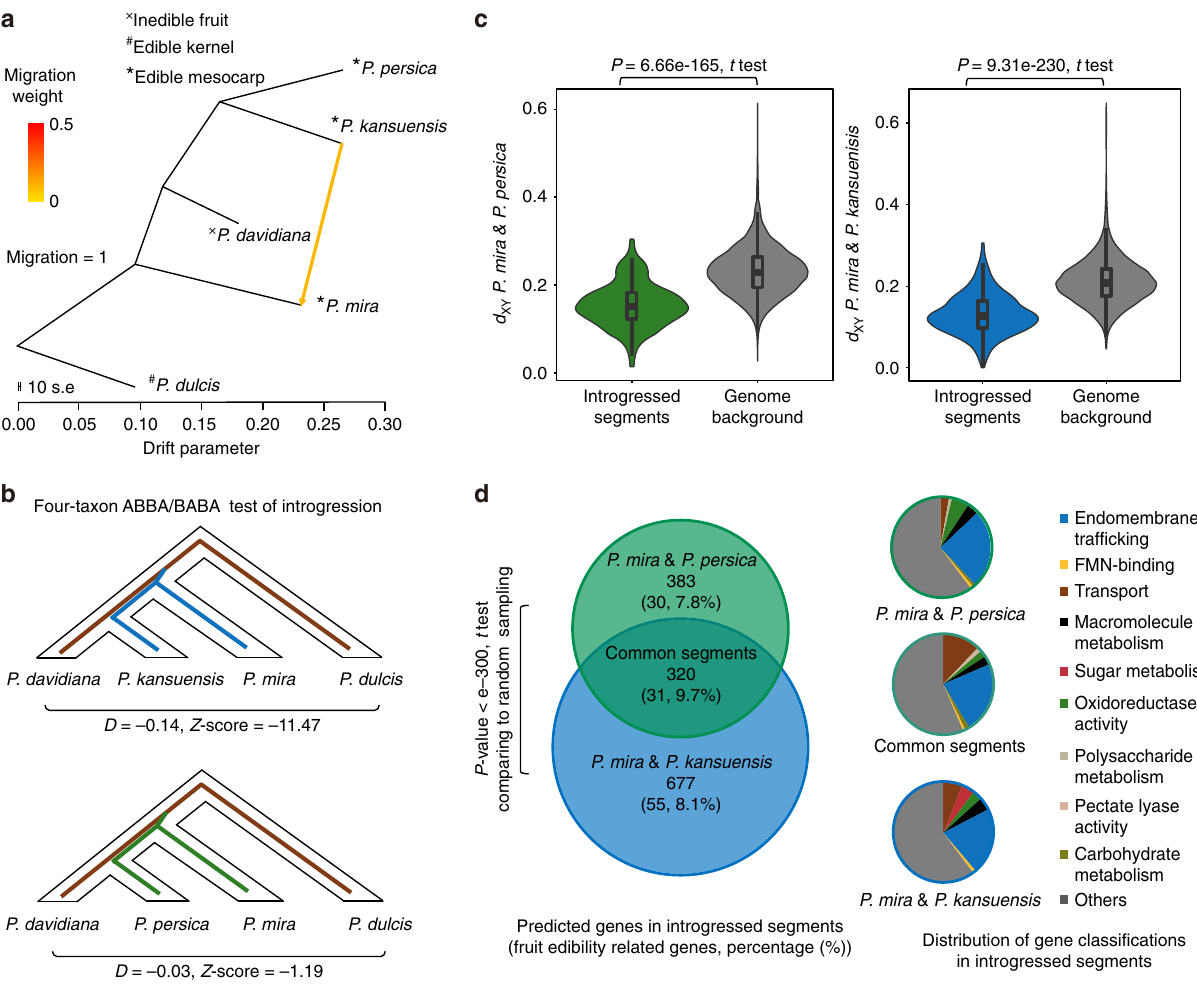
Fig. 4 The emergence of fruit edibility in peach species. a TreeMix analysis of P. mira , P. davidiana , P. kansuensis , and P. persica , using P. dulcis as the outgroup. A signi fi cant gene fl ow from P. kansuensis to P. mira was observed when migration = 1. b Four-taxon ABBA/BABA test of introgression. The excess of shared derived alleles (indicated by D values and Z -scores) were observed between P. kansuensis and P. persica , and between P. mira and P. persica . c d XY values of the introgressed segments and genome background for introgression between P. mira and P. kansuensis and between P. mira and P. persica . Signi fi cantly lower d XY values were observed in introgressed segments compared to the genome background. Horizontal lines at the center of each box show median values. Bounds of each box show the quartiles. The upper whisker extends to last datum less than Q3 + 1.5*IQR, where IQR is the interquartile range (Q3 - Q1). The lower whisker extends to last datum larger than Q3 - 1.5*IQR. d Analyses of the predicted genes embedded in introgressed segments. The number and the proportion of putative genes related to fruit edibility within introgressed segments are given inside the parentheses of the Venn diagram. Functional categories containing signi fi cant enrichment of gene ontology (GO) terms were presented using pie charts. Signi fi cantly enriched ( P -value < 0.05, Fisher ’ s exact test) terms related to fruit edibility were classi fi ed into categories (Supplementary Data 6) based